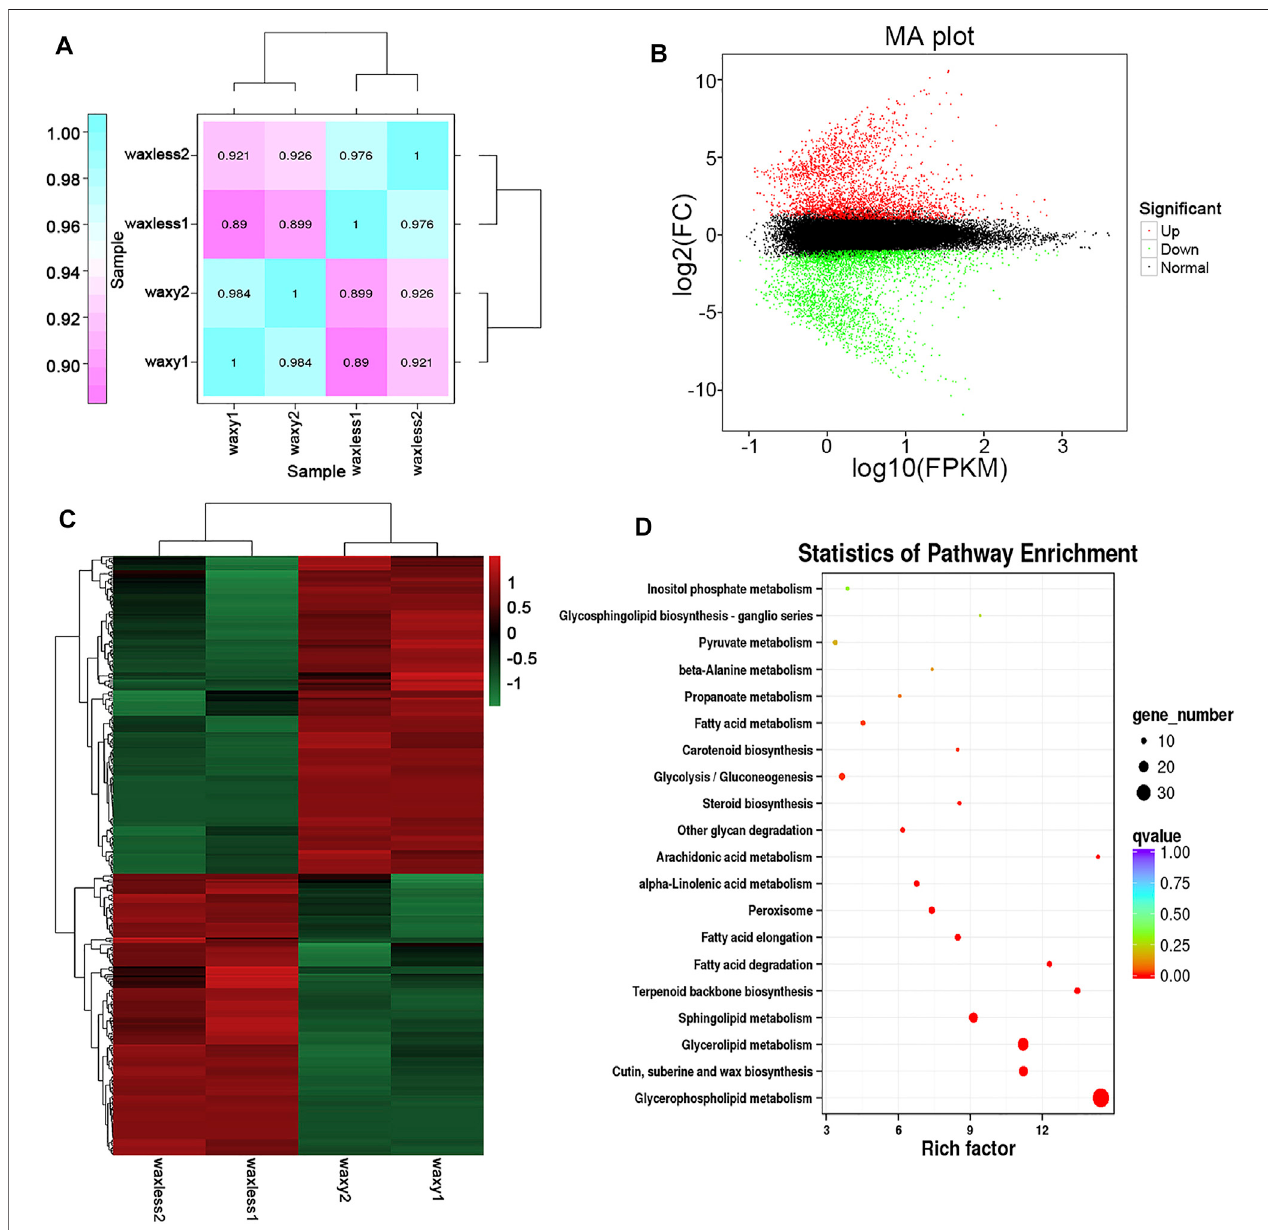
FIGURE 6 | Transcriptome data analysis. (A) The expression quantity correlation heatmap of the sample. The numbers in each cell represent the correlation coef fi cients. (B) MA plot of DEGs, each dot in the MA map of differentially expressed genes represents a gene. Abscissa is value A: log 10 (FPKM), ordinate is value M: log 2 FC( waxless / waxy ), green dots represent the downregulated DEGs, red dots represent the upregulated DEGs, and black dots represent the non-differentially expressedgenes. (C) Theheatmappresentationoffoldchangesof343DEGsobtainedfromRNA-seqanalysis. (D) EnrichmentandscattermapofKEGGpathway of DEGs. Each circle in the fi gure represents a KEGG pathway, ordinate represents the name of the pathway, and abscissa is the enrichment factor. The greater the enrichment factor, the more signi fi cant the enrichment level of DEGs in this pathway. The color of the circle represents the qvalue. The size of the circle indicates the number of genes enriched in the pathway, and the larger the circle, the more the